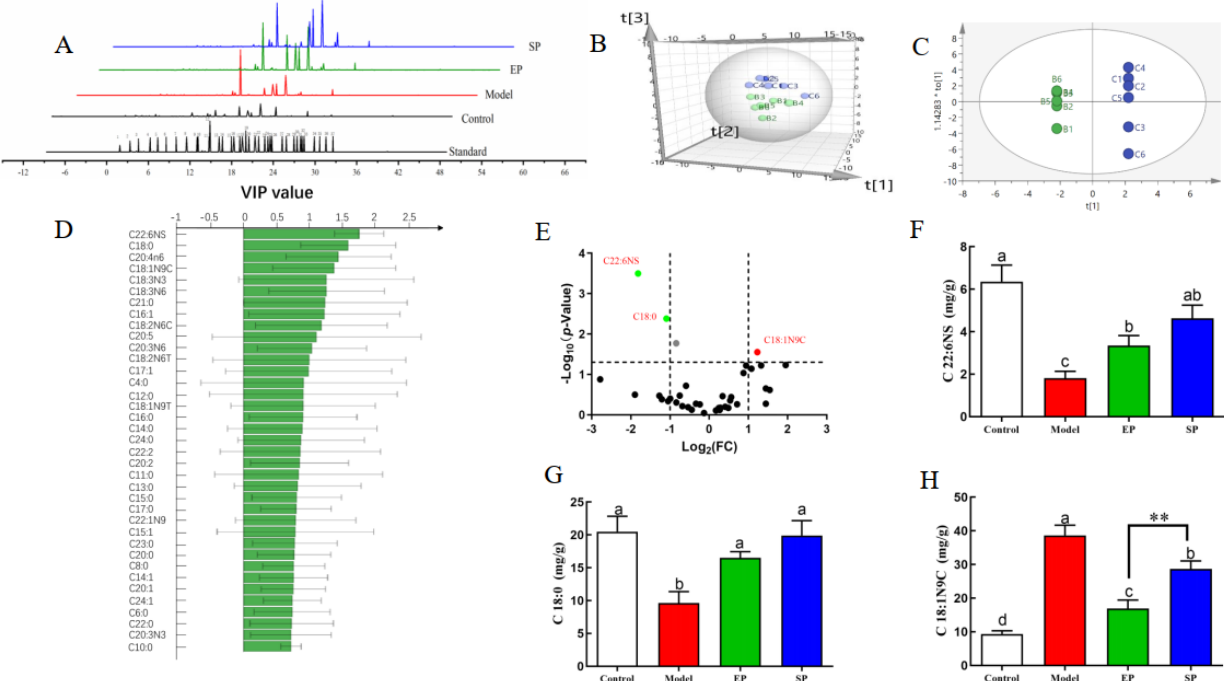
Figure 3. Treatment with phospholipid changes in hepatic fatty acid profiles. ( A ) Total ion chromatogram of liver samples and 37 fatty acid methyl esters standard, ( B ) PCA score 3D plot and ( C ) OPLS-DA score plot, ( D ) VIP scores of OPLS-DA, and ( E ) volcano plot for liver fatty acids of normal and HFD-fed rats. Potential biomarkers of fatty acid metabolism in